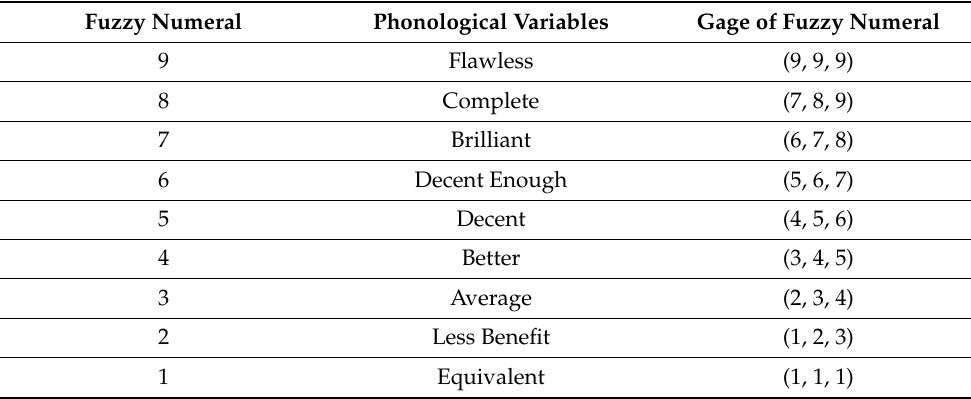
Table 3. Membership role of phonological